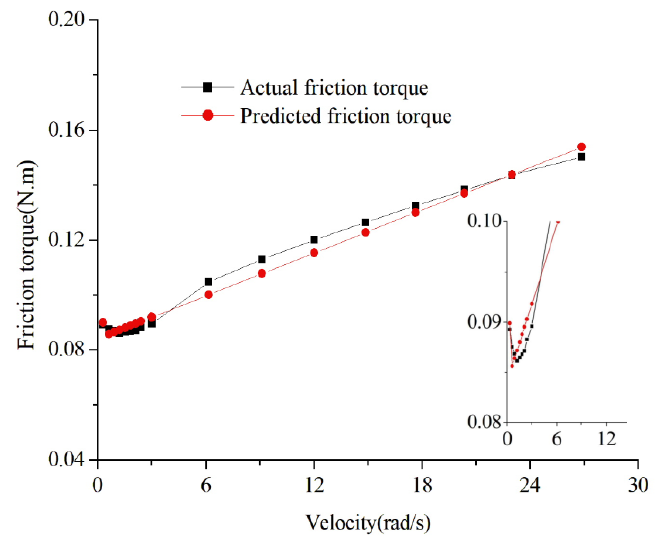
Figure 8. Friction torque prediction curves of RWSAVSBAS algorithm.